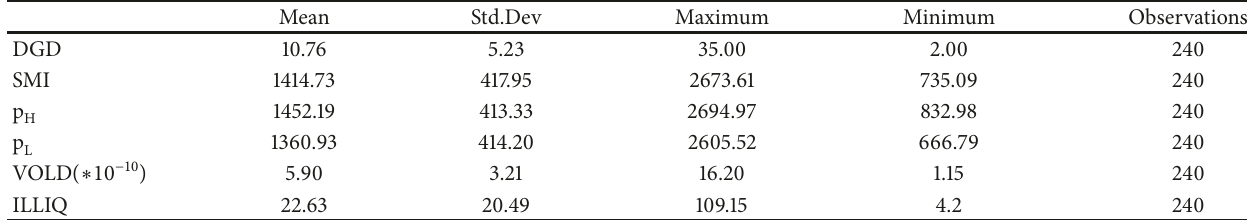
Table 2: Summary of Statistics.